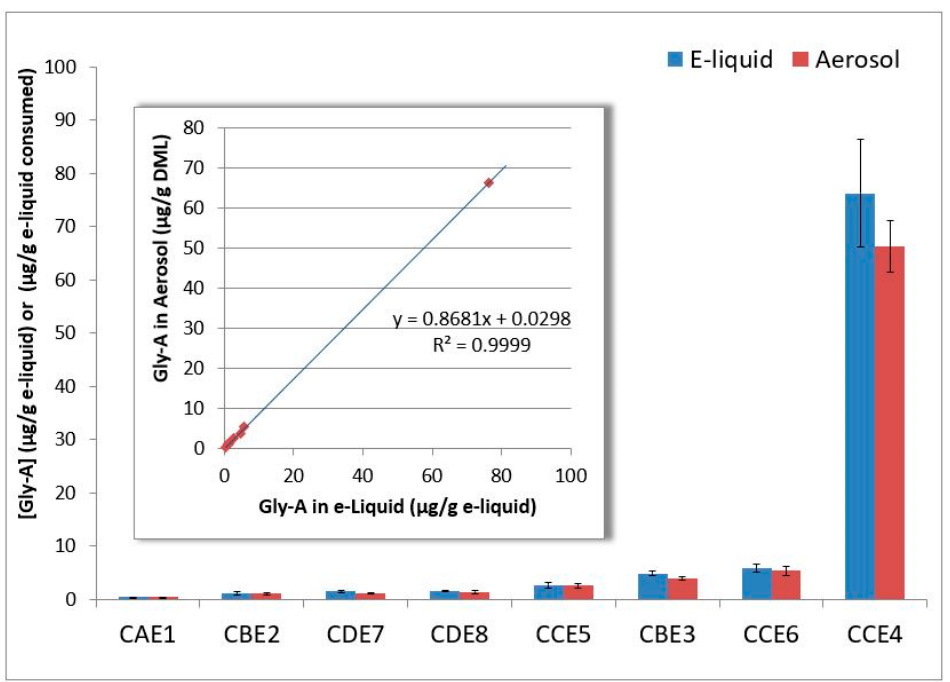
Figure 5. Gly-A average concentrations (n = 4) measured in e-liquid (µg/g e-liquid) and aerosol emission (µg/g e-liquid consumed) cig-a-like device category. Inset plot: e-liquid content vs. aerosol emissions.